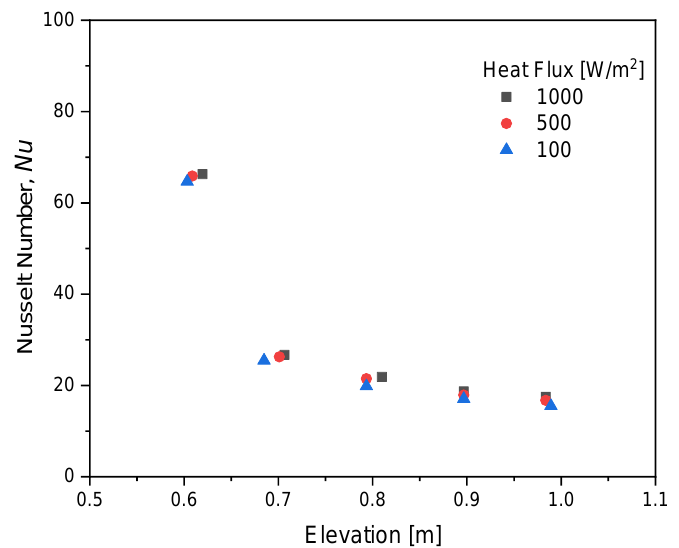
Figure 14. Nusselt number ( Nu ) for laminar flow against altitude with variations in heat flux at various positions.